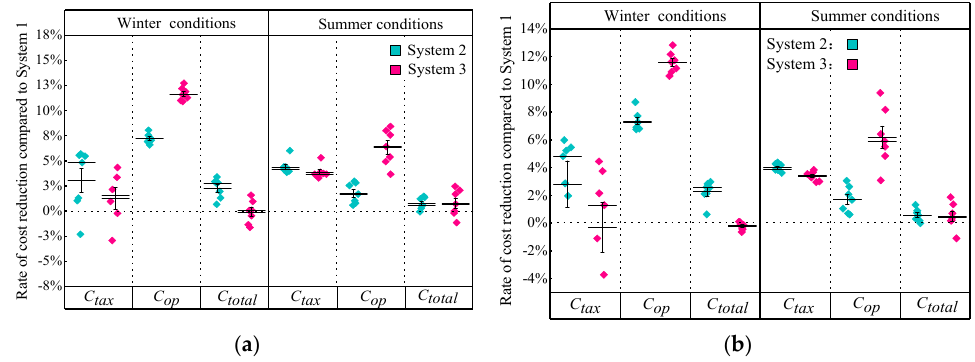
Figure 14. Cost reduction rates of system 2 and system 3 compared with system 1 under changes in electricity and gas prices: ( a ) Affected by changes in electricity prices; ( b ) Affected by changes in gas prices.